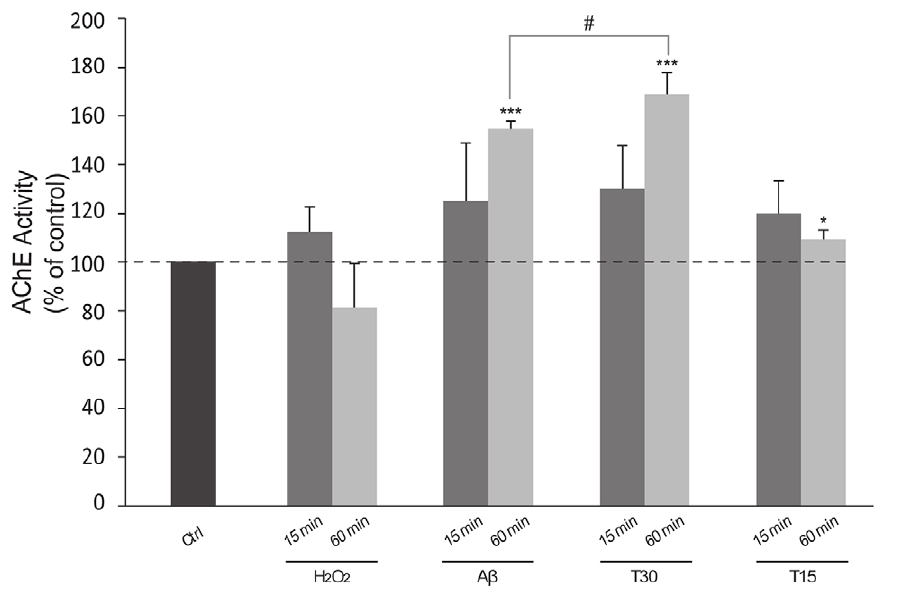
2 O 2 ) 100 m M, b -Amyloid (A b ) 0.7 m M, AChE C-terminus peptides of 30 amino acids (T30) 0.7 m M and the residual 15 amino acid sequence (T15) 0.7 m M. Data are presented as the percentage of the mean 6 S.E.M. divided by the number of extant cells and obtained from independent experiments carried out on triplicates. * P , 0.05 and *** P , 0.001 vs Control; # P , 0.05 between T30 treatments. Dotted line shows basal AChE activity (Control 100%).